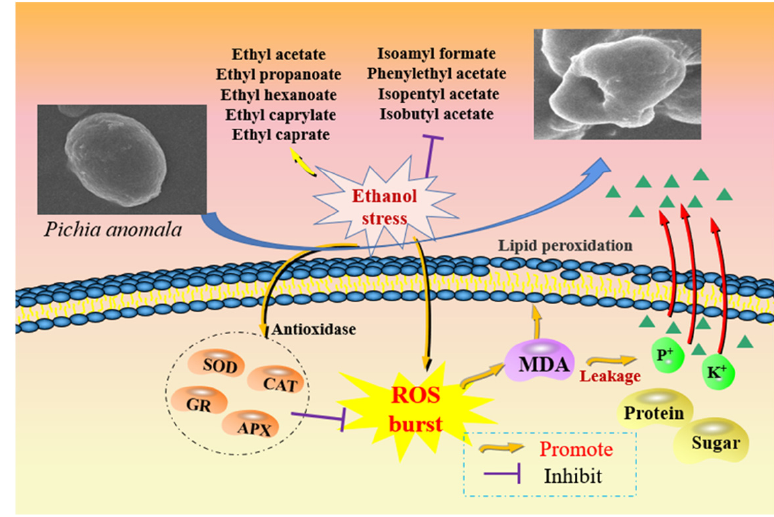
Figure 7. Schematic diagram of the influence mechanism of ethanol stress on P. anomala .